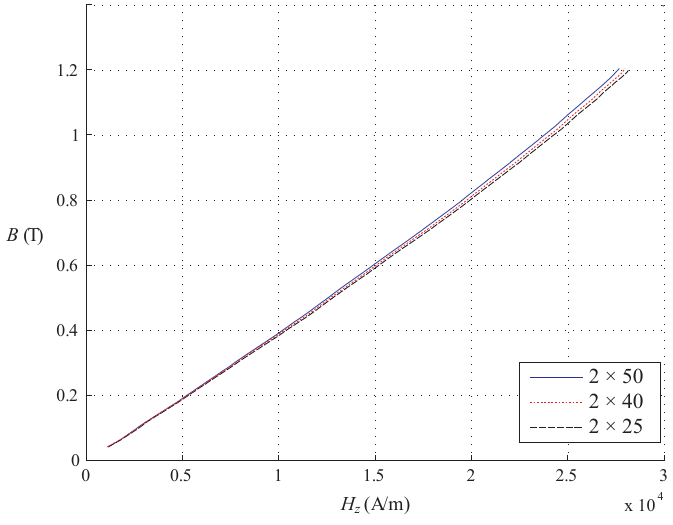
of the sheet samples for various n z